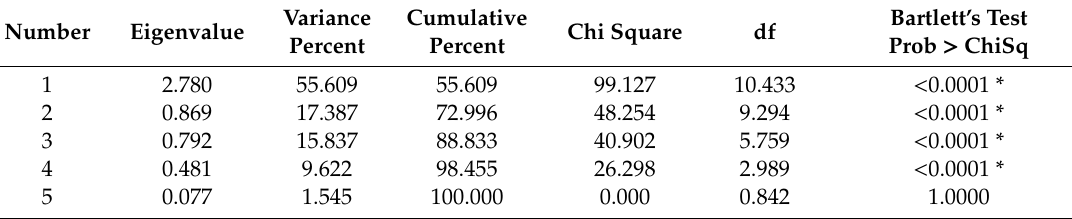
Table 3. Eigenvalues, percentage, and Bartlett’s sphericity test of the principal components (PCs).